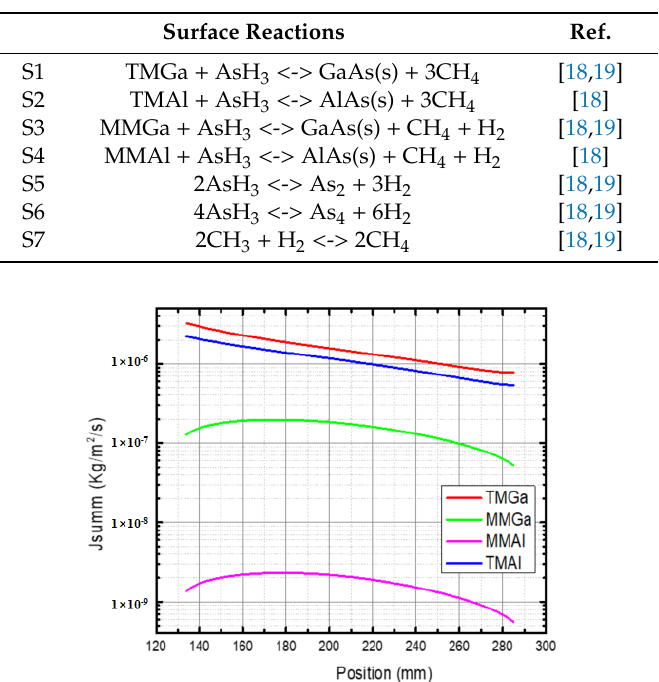
Figure 2. Simulated results of the mass fluxes of the AlGaAs materials along the susceptor radius r. Gases inlet at reactor chamber centre (r = 0 mm), and the substrate located at 134 nm to 285 nm. P = 5 × 10 3 Pa, T growth = 700 °C, total AsH 3 flow rate Q AsH3 = 600 sccm, carrier gas flow rate Q H2 = 37 slm.